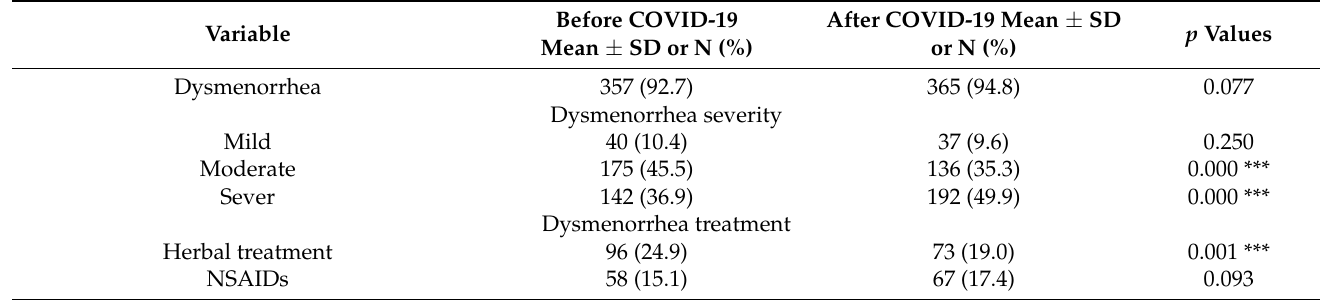
Table 2. Dysmenorrhea and premenstrual syndrome changes of female medical students before and after